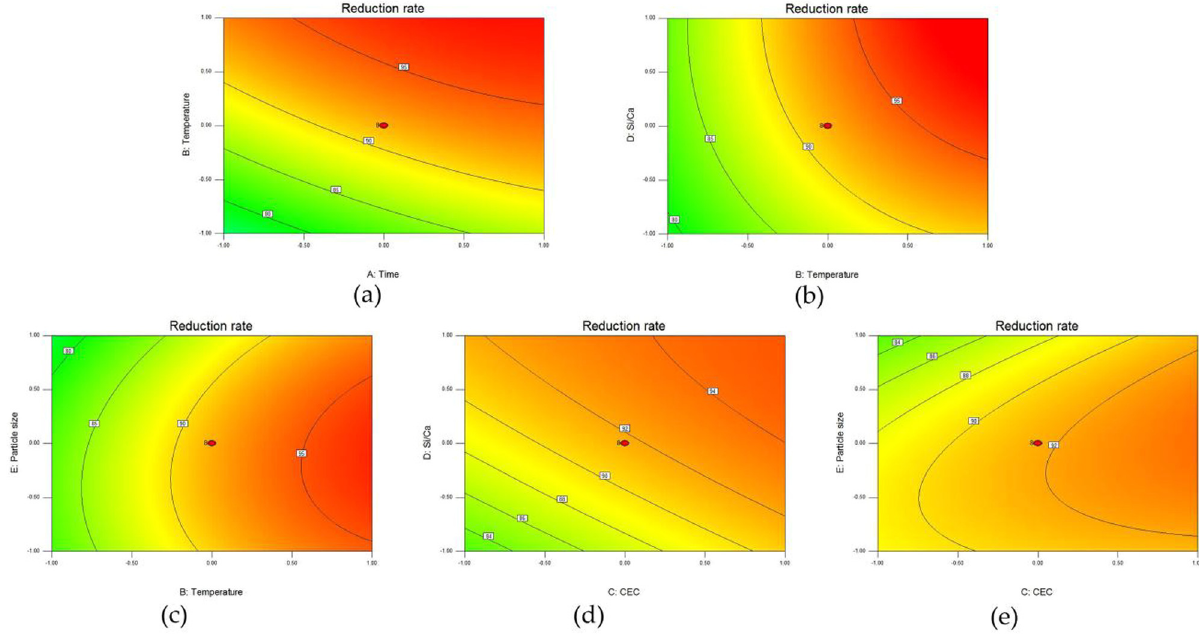
Figure 4: Contour plot showing the e ff ects on reduction rate. ( a ) Fixed levels C ( 1.20 ) , D ( 1.20 ) , E ( 75 – 106 µm ) . ( b ) Fixed levels A ( 75 min ) , C ( 1.20 ) , E ( 75 – 106 µm ) . ( c ) Fixed levels A ( 75 min ) , C ( 1.20 ) , D ( 1.20 ) . ( d ) Fixed levels A ( 75 min ) , B ( 1,300°C ) , E ( 75 – 106 µm ) . ( e ) Fixed levels A